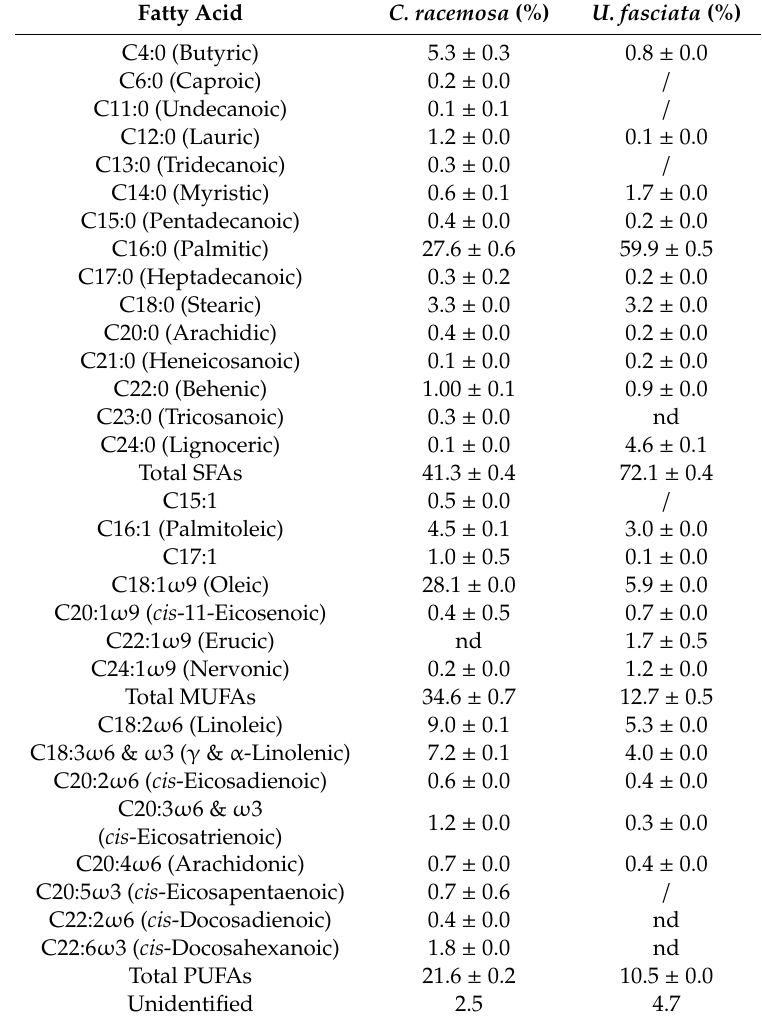
Table 2. Fatty acids (% of total fatty acids (TFAs)) of Caulerpa racemosa and Ulva fasciata . Fatty Acid